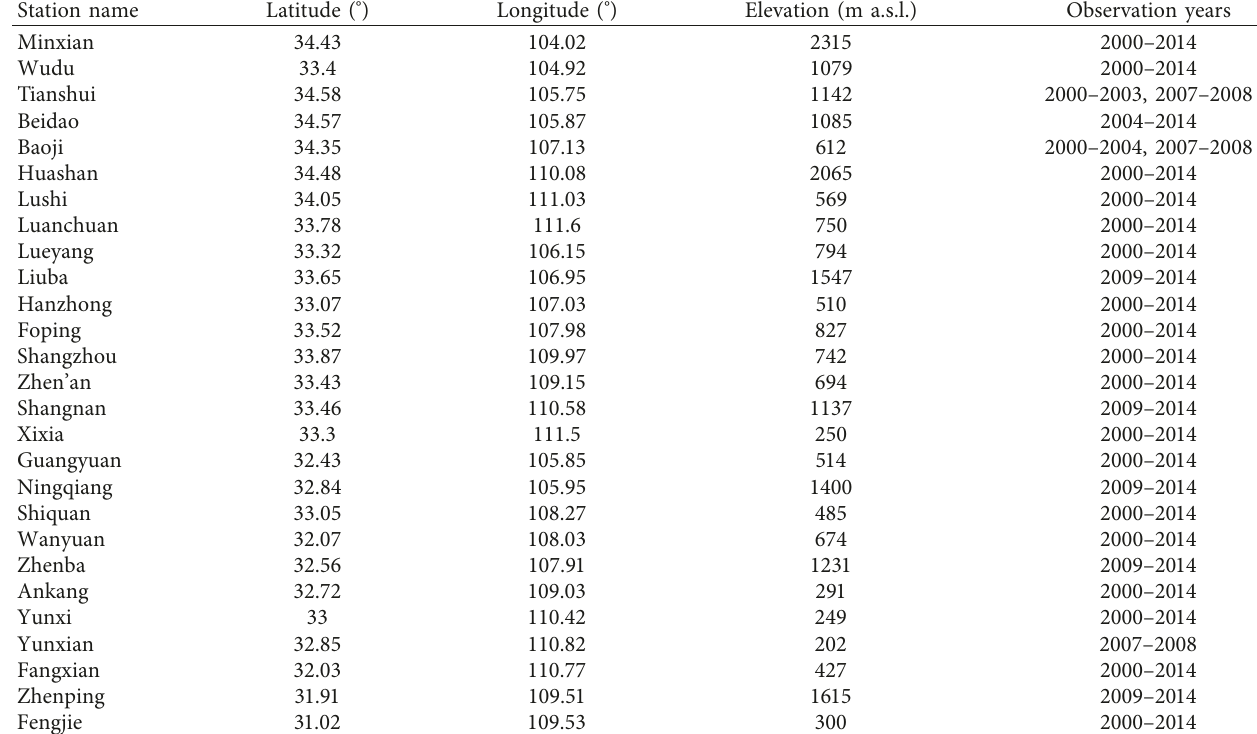
Table 1: The basic information of gauge station over the Qinling-Daba Mountains,